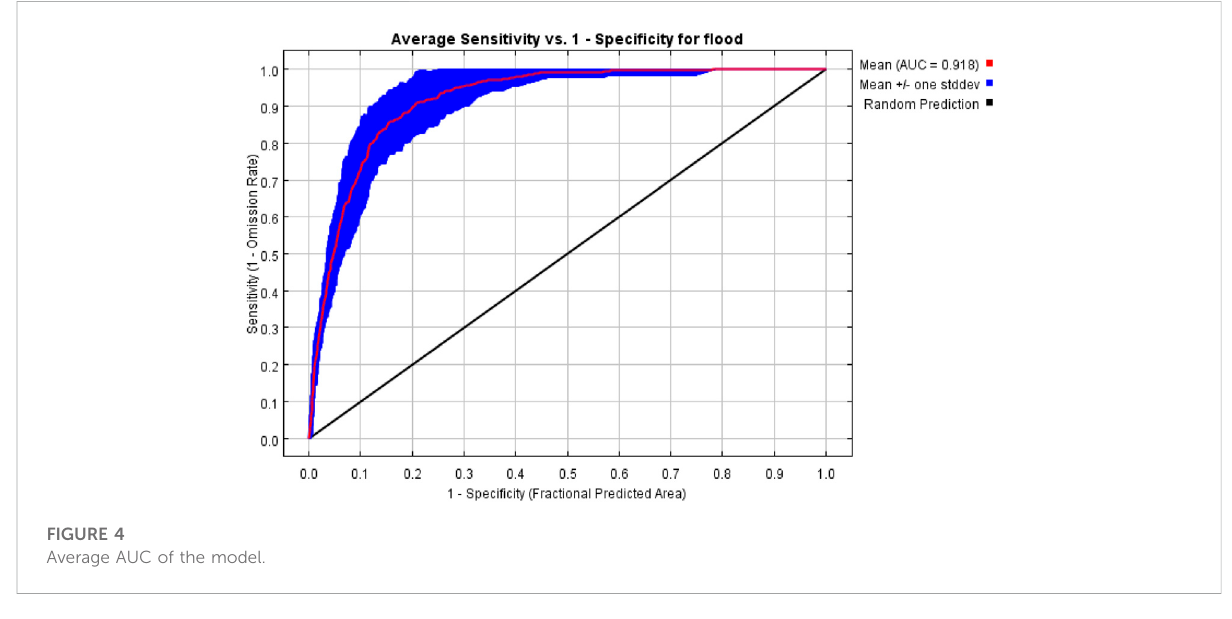
FIGURE 4 Average AUC of the